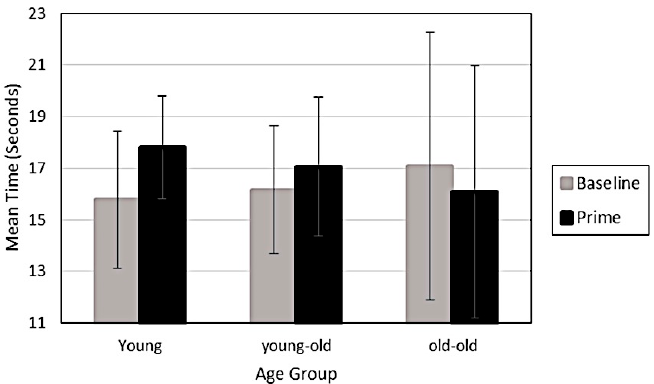
Figure 3. Mean time and standard error for all 3 age groups in the “down to the left” orientation at baseline and then after Priming, where the prime cube in the “up to the right” orientation was viewed for 5 s prior to viewing the Necker cube.